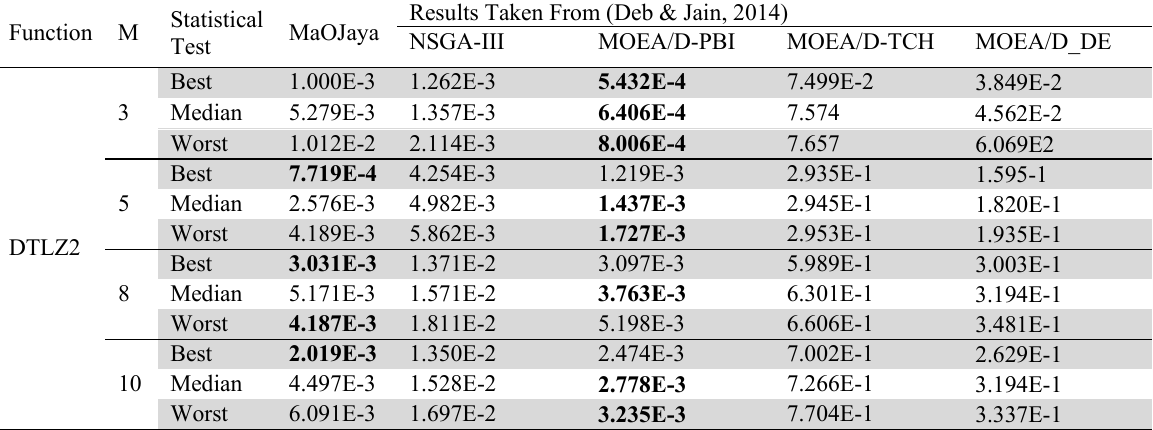
Best results are indicated in bold face Table 4 Comparison of IGD values of DTLZ3 Function Results Taken From (Deb & Jain, 2014) Statistical Function M MaOJaya Test